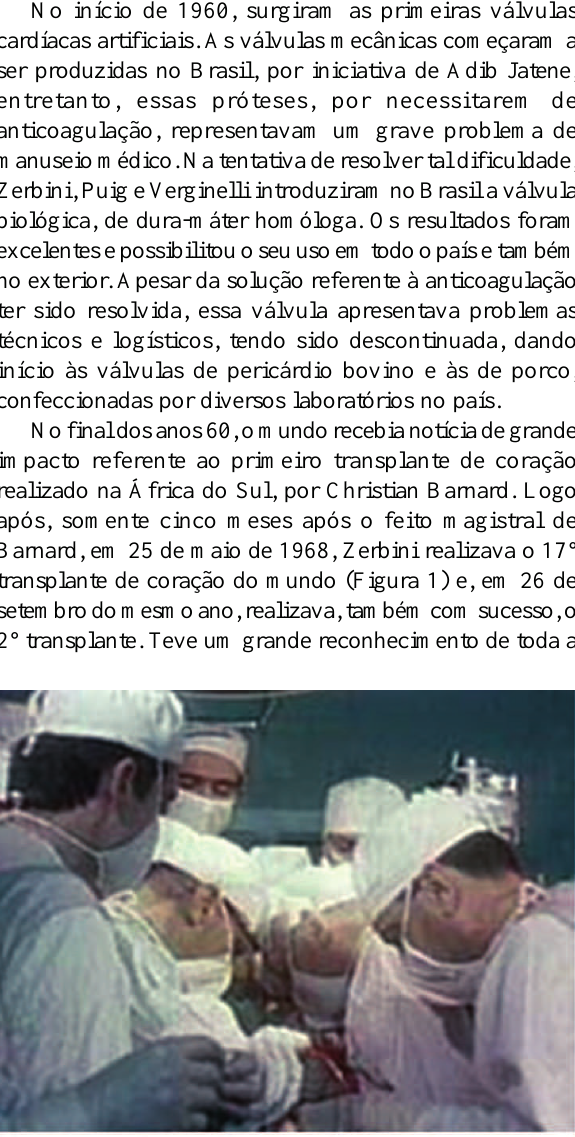
Fig. 1 – Dr. Zerbini e equipe realizando o 1° transplante cardíaco, em